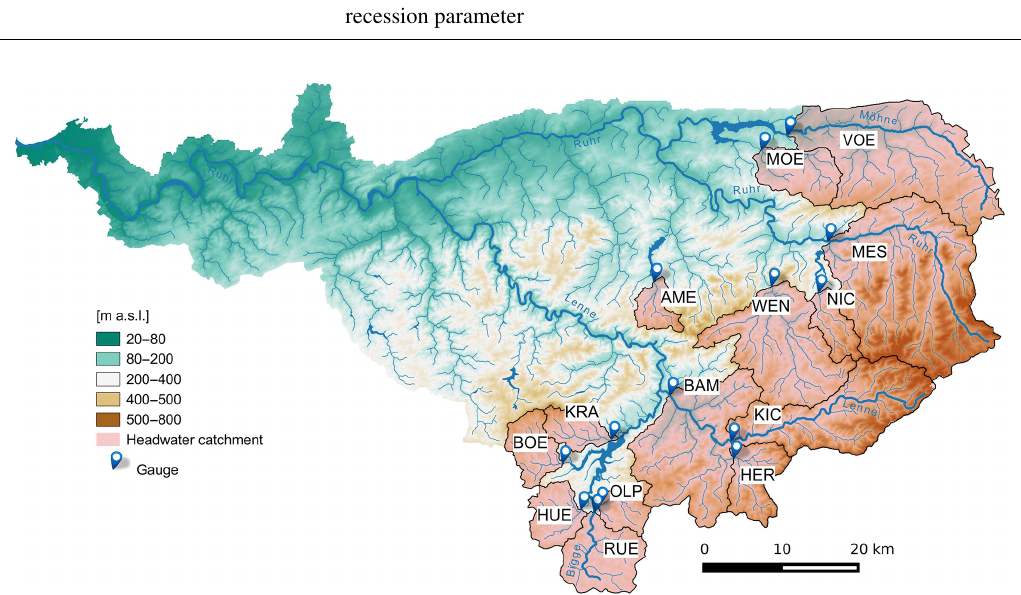
Figure 1. The Ruhr catchment with altitudinal zones, river network and 14 gauged headwater catchments: Amecke (AME), Bamenohl (BAM), Börlinghausen (BOE), Herrntrop (HER), Hüppcherhammer (HUE), Kickenbach (KIC), Kraghammer (KRA), Meschede1 (MES), Möhnesee-Neuhaus (MOE), Nichtinghausen (NIC), Olpe (OLP), Rüblinghausen (RUE), Völlinghausen (VOE), and Wenholthausen